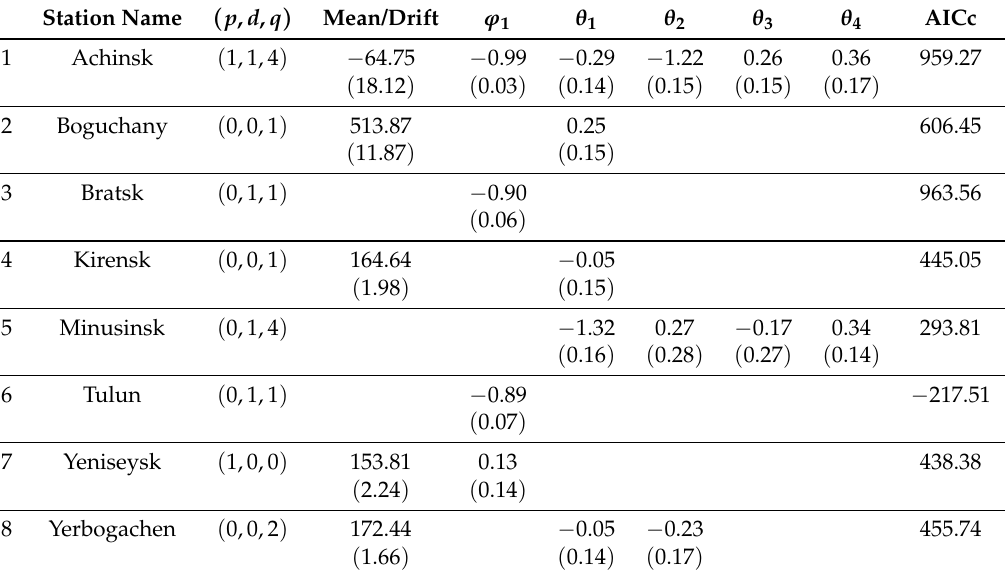
Table 4. Estimates and performance characteristics for the best ARIMA models